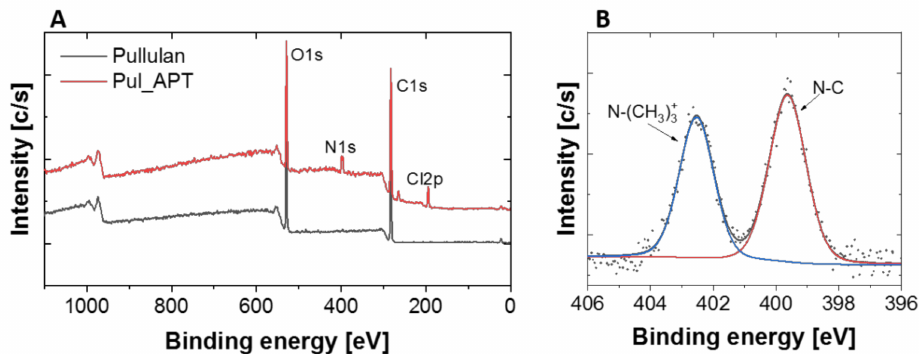
Figure 4. XPS spectra of: ( A ) pullulan and C-PUL survey; ( B ) N1s spectrum of C-PUL.